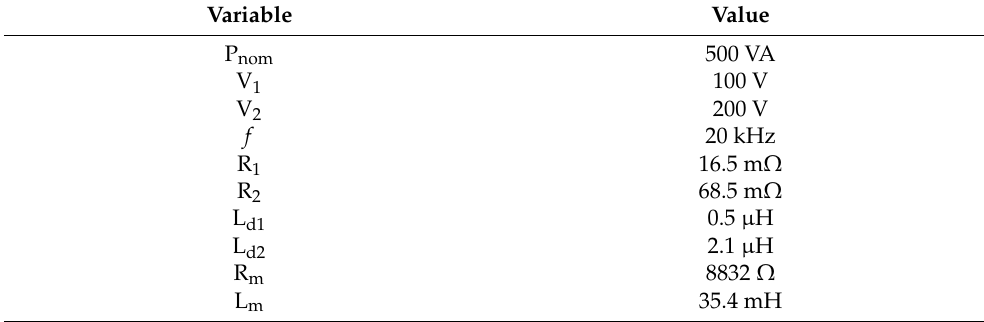
Table 1. MFT ’s Parameters.